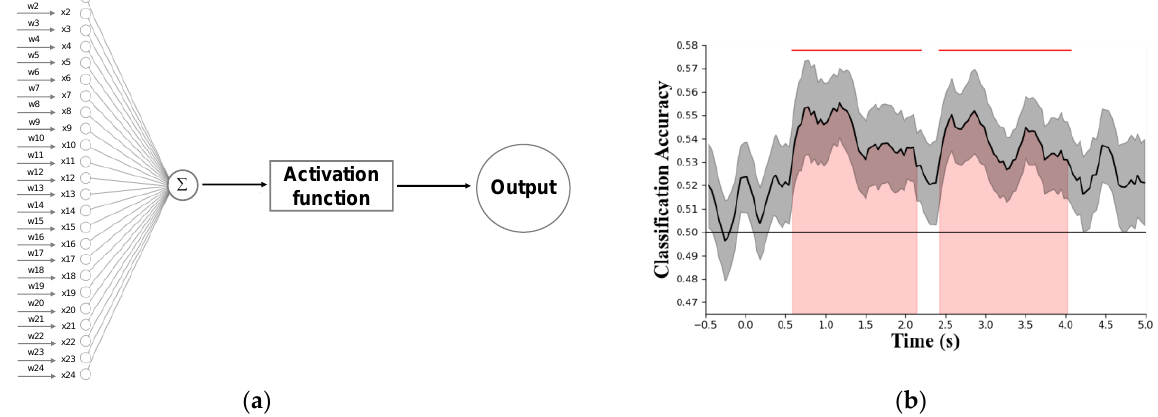
Figure 8. MVPA algorithm based on single-layer perceptron neural network architecture and decoding accuracy. ( a ) Input nodes x i denote the SNR or amplitude of 24 EEG channels at the interested IM frequency. ω i denotes the weight of inputs. The sigmoid function is often used as the activation function in the single-layer perceptron neural network. Finally, by summing the weighted signals and nonlinear activation processing, it can be inferred which experimental condition produced the current IM pattern. ( b ) A simulated decoding accuracy profile, time-by-time. The solid black line denotes the chance level of decoding accuracy. The red-shaded area and solid red line above indicates that the single-layer perceptron neural network model can significantly distinguish under which experimental condition the current IM pattern is generated in the current time